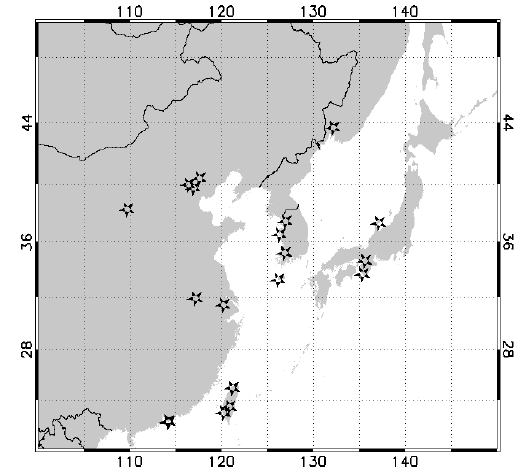
Fig. 1. Map of the study area (20 ◦ –50 ◦ N, 100 ◦ –150 ◦ E). The rectangular box represents a sub-area for the case study. Twenty AERONET sun-sky radiometer measurement sites are indicated by stars. Geographic locations for each site are available on the AERONET webpage